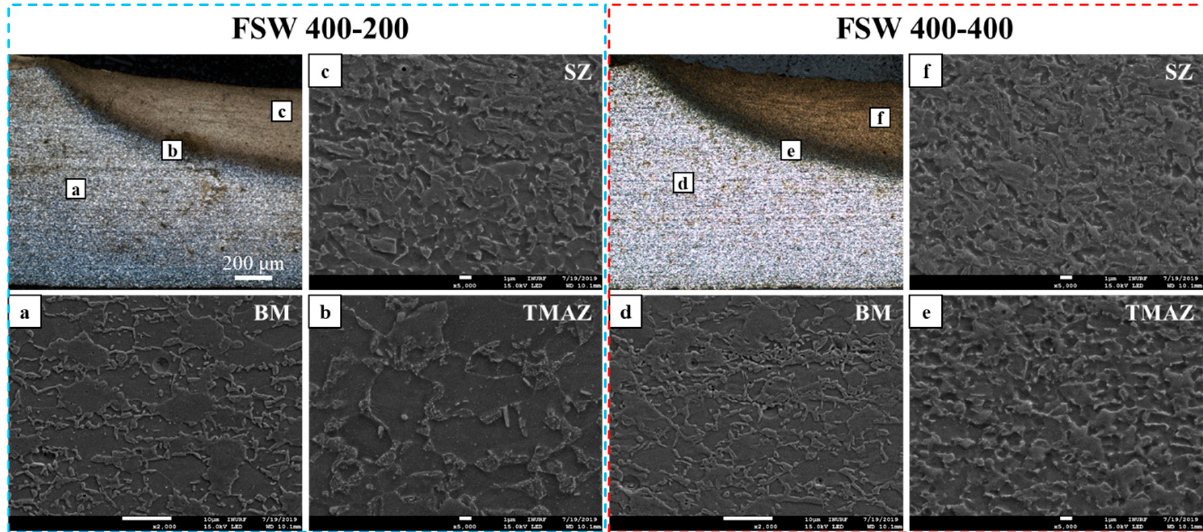
Figure 2. The optical micrograph and SEM images showing the ( a ) BM, ( b ) TMAZ, ( c ) SZ of the FSW400-200 and ( d ) BM, ( e ) TMAZ, ( f ) SZ of the FSW400-400 samples.